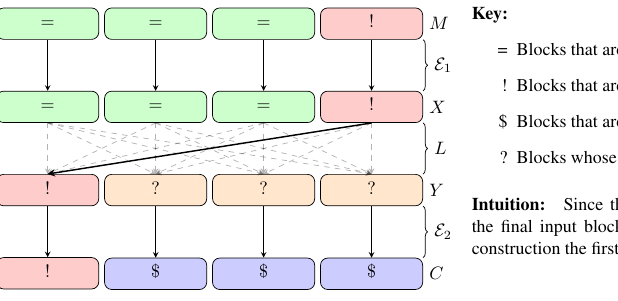
Figure 9: An attack against the prp • security of Π L